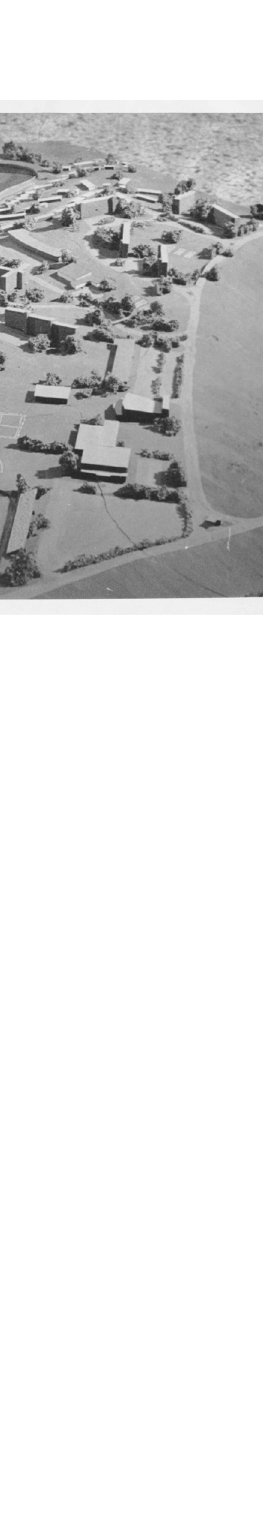
Fig. 11 Physical model of the proposed site for “Jerusalem University” indicating all programs on cam- pus programs and spaces in connection to the urban fabric of the city. Source: Saba Shiber, “A University City for the Pro- posed Jerusalem University,” Master’s thesis, MIT,